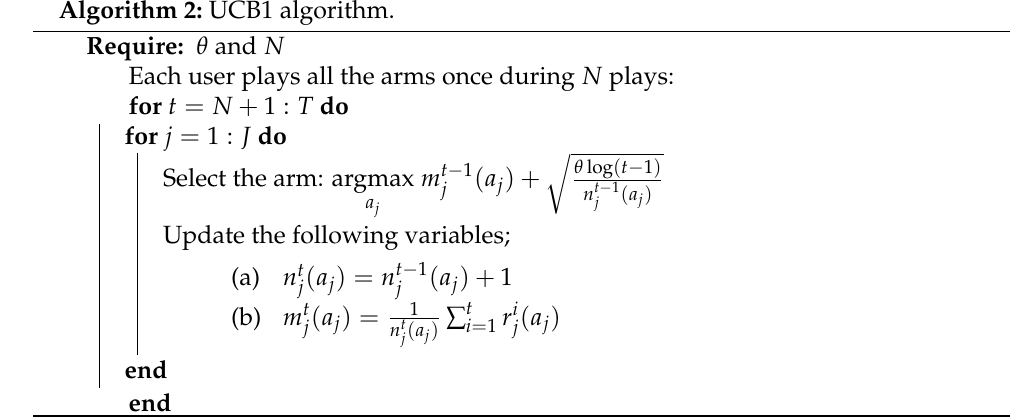
Algorithm 2: UCB1